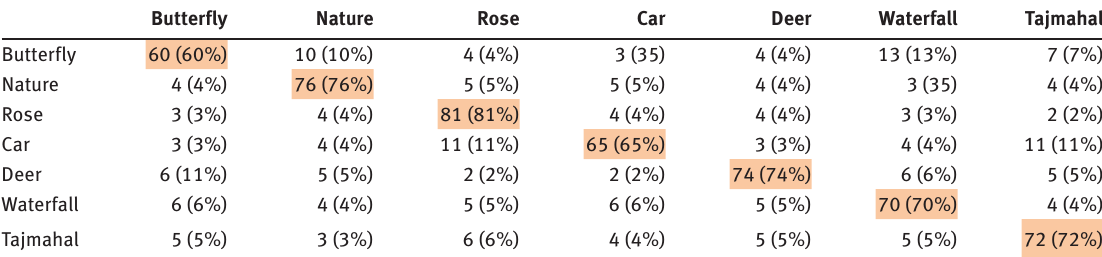
Table 2: Confusion Matrix for Theorem 2.